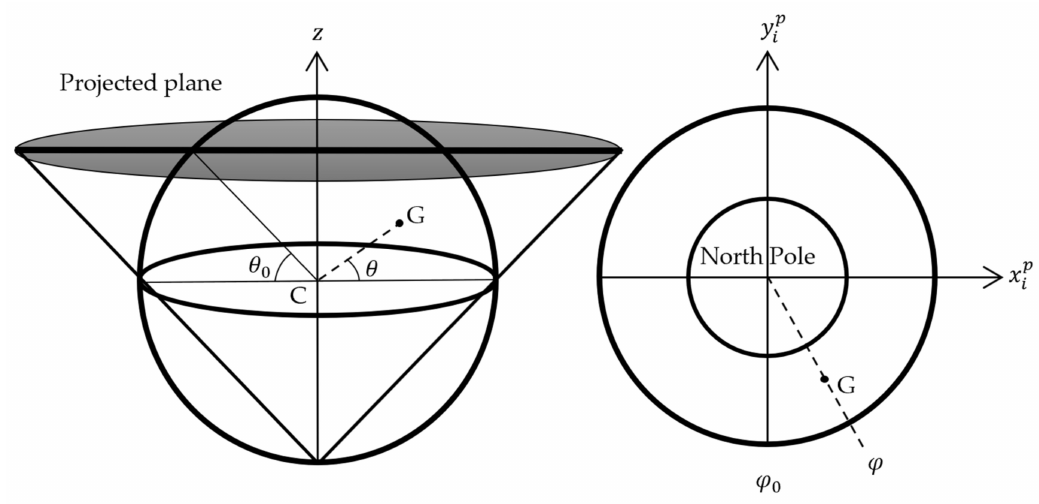
Figure A1. Polar stereographic projection